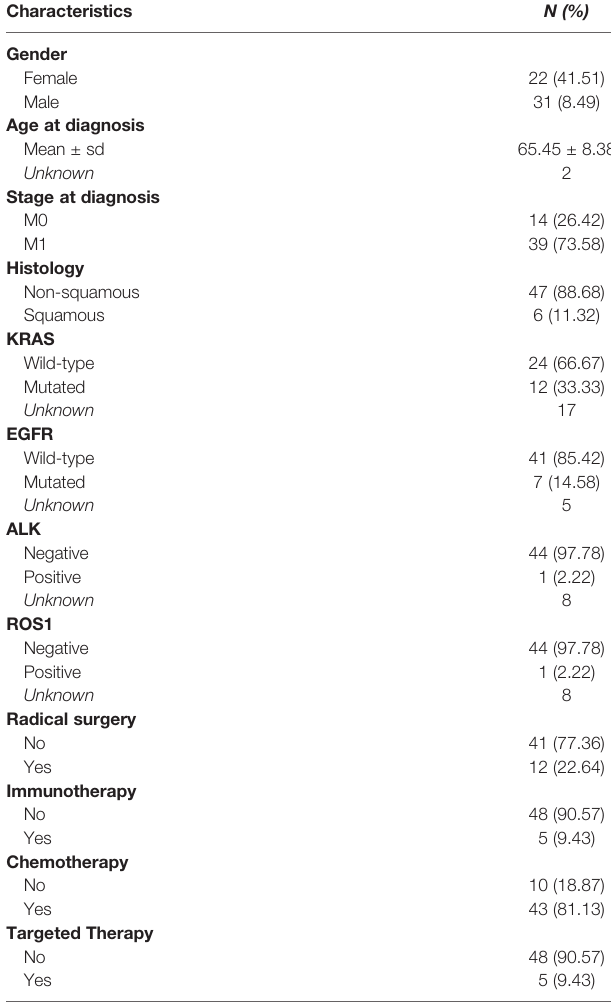
TABLE 1 | Patient characteristics ( N =